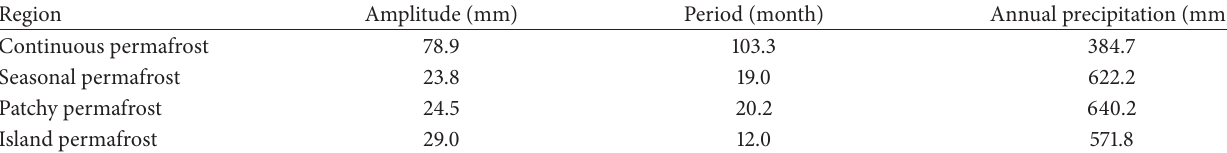
Table 3: Period of water storage change over different types of permafrost in the Three-River Source Region during 2003–2010.